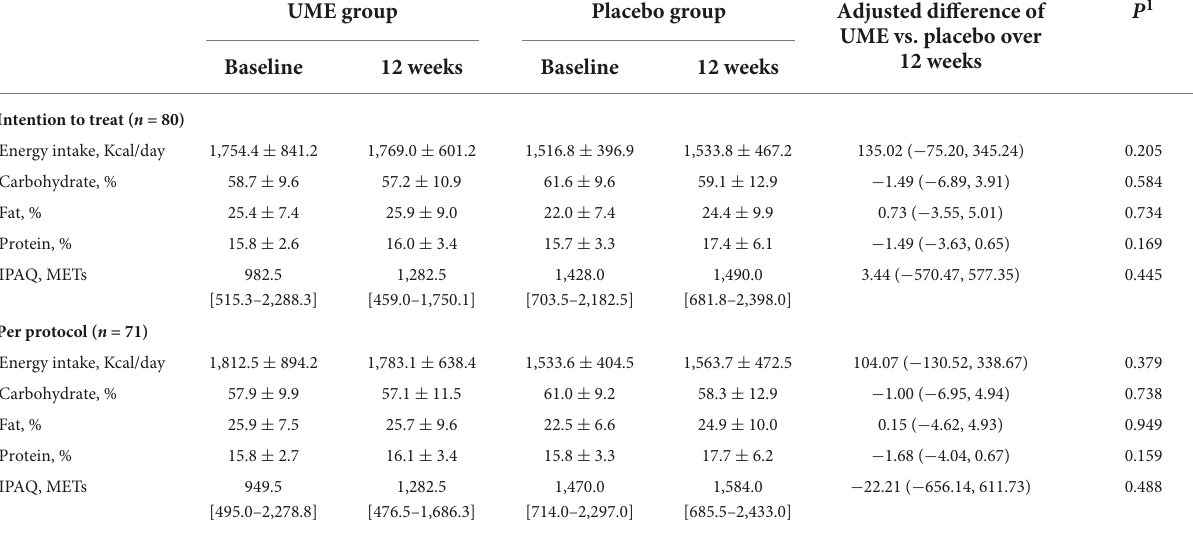
TABLE 2 Energy intake and physical activity between the two groups for 12